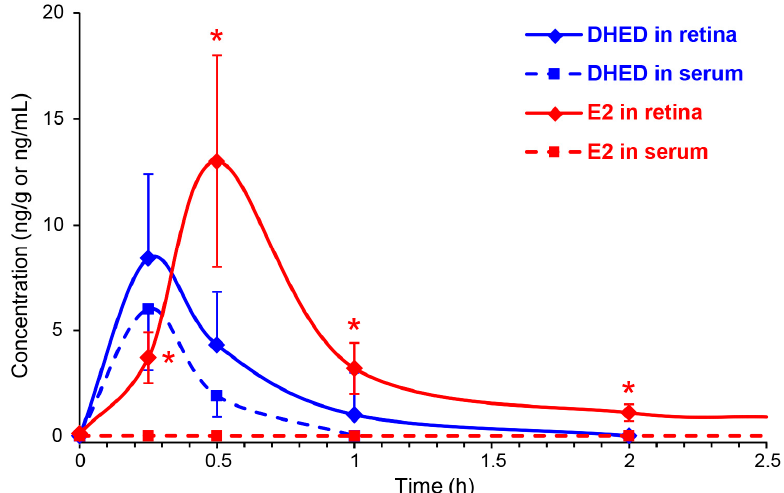
Figure 3. DHED (blue) and E2 (red) concentrations in the retina (solid line) and blood (dashed line) after a single eye drop (10 μ L) of 0.1% w/v DHED into the eyes of ovariectomized (OVX) rats. Data are mean ± SD, n = 4. * p < 0.05 compared to control (displayed at 0 h).